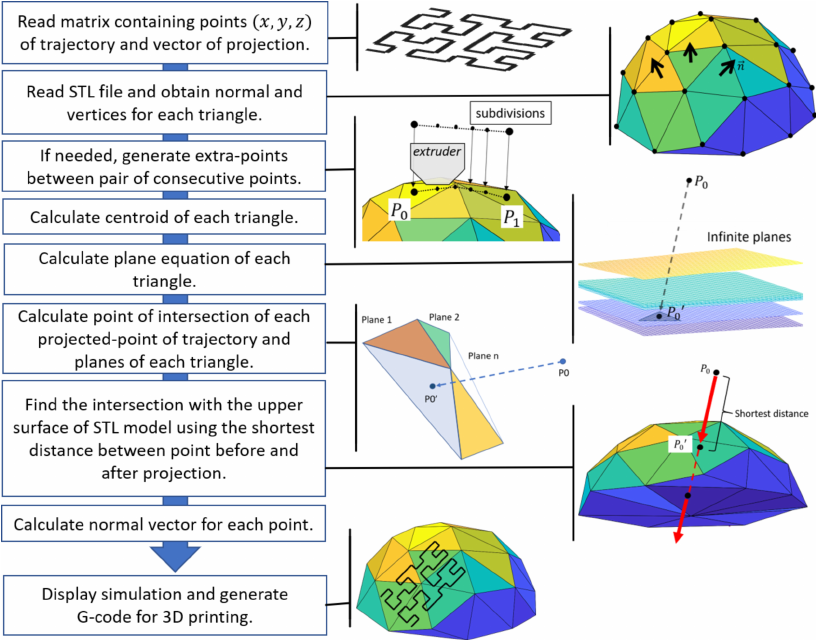
Figure 3. Flow diagram of the algorithm presented here for conformal 3D